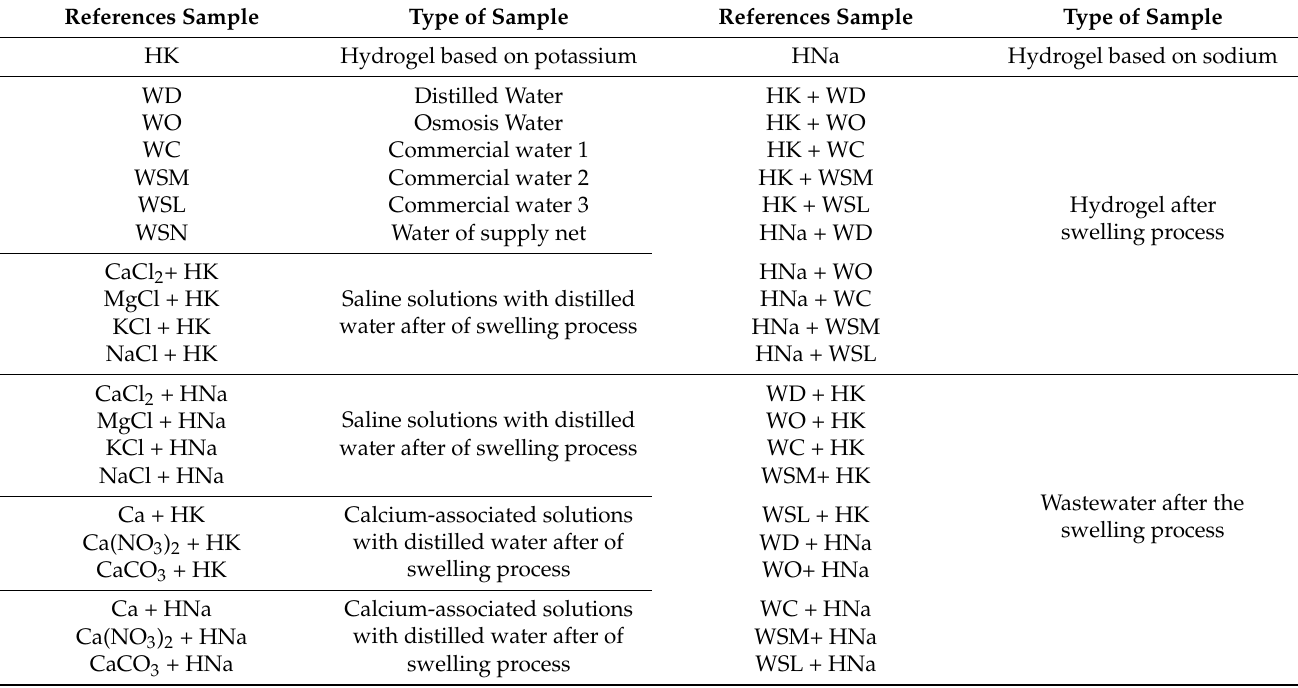
Table 3. Samples of water and residual water from the swelling process.